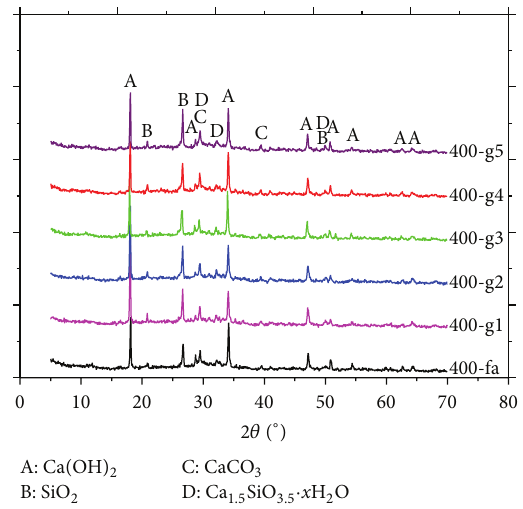
Figure 8: XRD patterns of the test specimens.